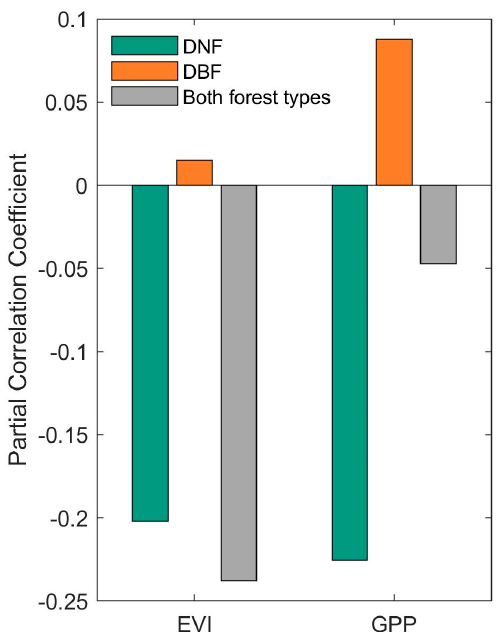
Figure 5. Partial correlation coefficient between TS EVI and TS GPP and the standard deviation of SPEI12. In this research, all of the correlations were significant ( p < 0.001).